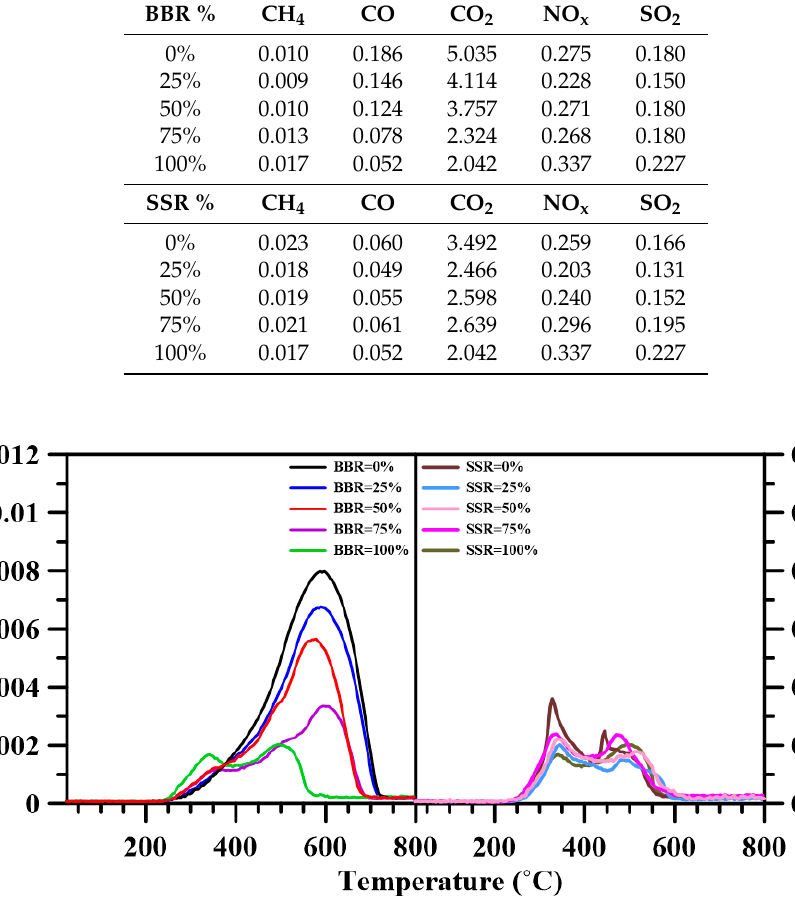
Figure 12. Evolution of CO 2 for various sludge-coal and sludge-shiitake ratios in TGA-FTIR.